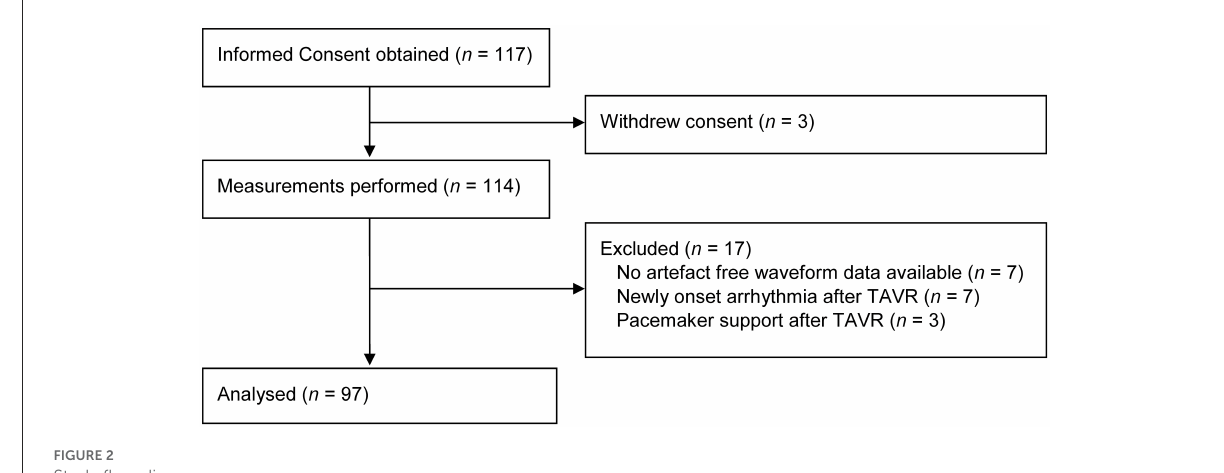
FIGURE2 Study flow